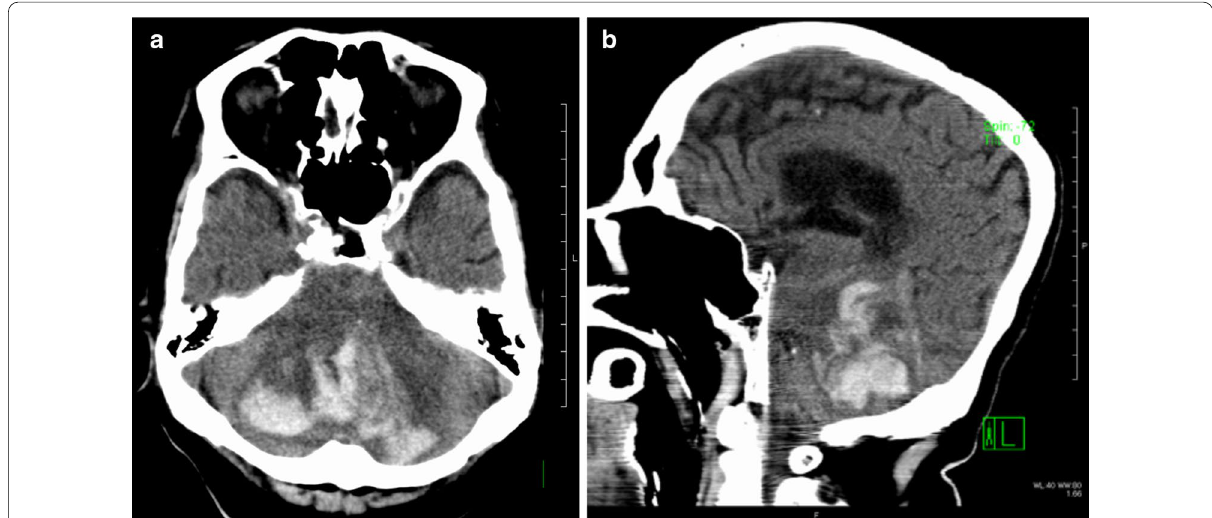
Fig. 2 Brain computed tomography (CT) images of case 1. Brain CT revealed cerebellar bleeding on POD 27